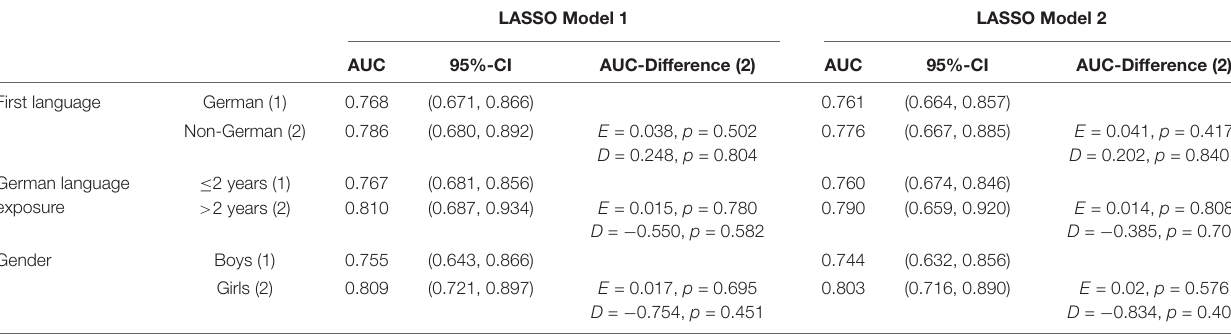
TABLE 3 | Comparing receiver operating characteristics (ROC) curves between subsamples.